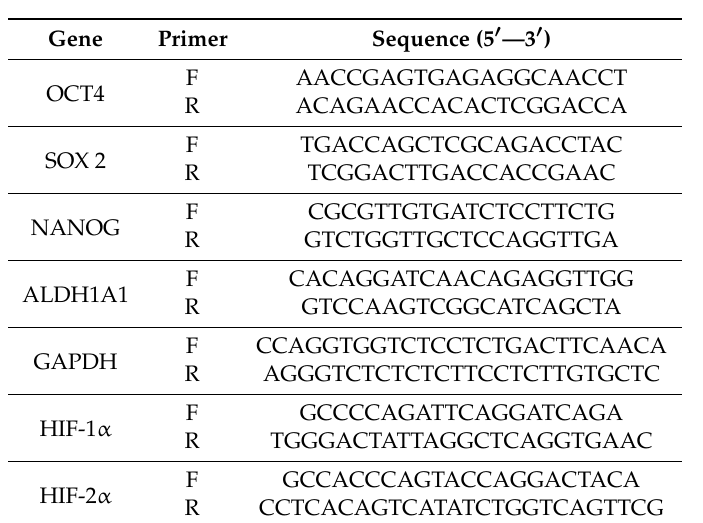
Table 1. Primers for